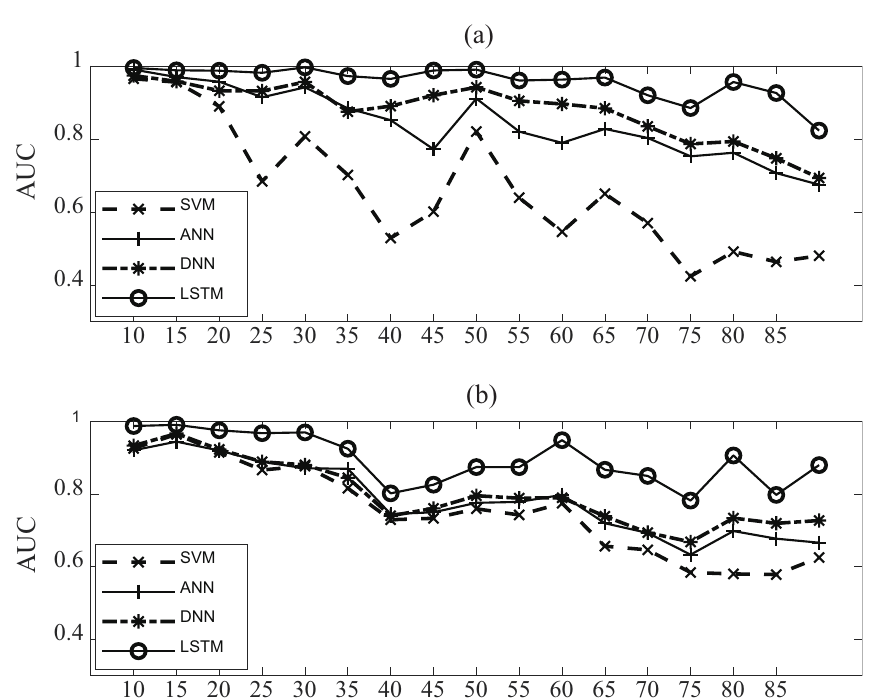
Figure 9. Performance plot of the proposed model and conventional model. ( a ) Result of the set1 DB, ( b ) Result of the set2 DB.